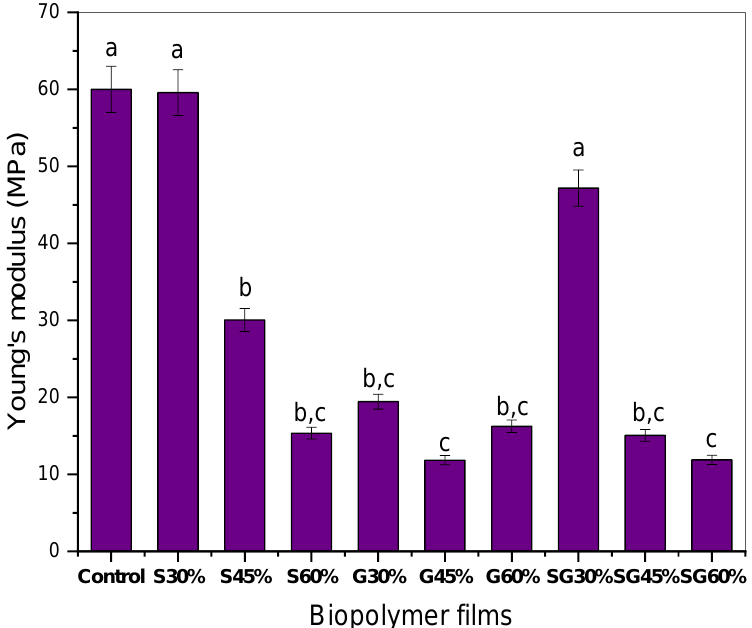
Figure 5. Young’s modulus of the cornstarch-based film with different plasticizers. a,b,c Values with different letters in the figures are significantly different ( p < 0.05).